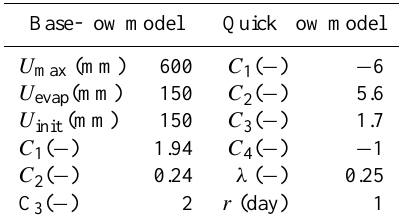
Table 2a. Calibrated parameters of the VHM model for Nyando catchment.